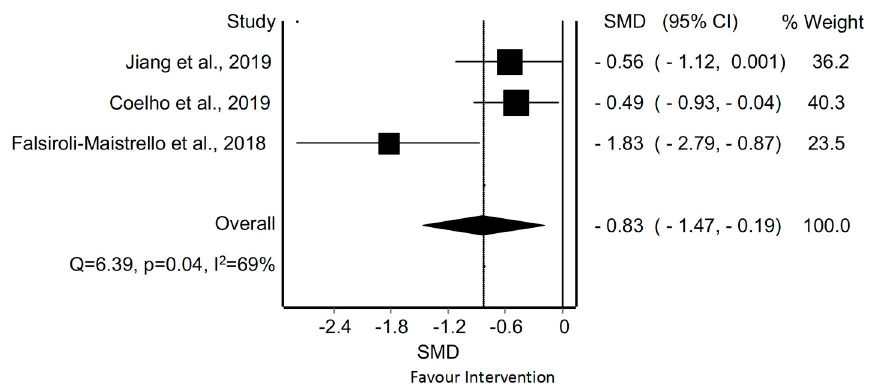
Figure 6. Synthesis forest plot for pain intensity in patients with tension-type headache treated with manual therapy. The forest plot summarizes the results of included studies (review size, standardized mean differences [SMDs] and weight). The small boxes with the squares represent the point estimate of the effect size and sample size. The lines on either side of the box represent a 95% confidence interval (CI).